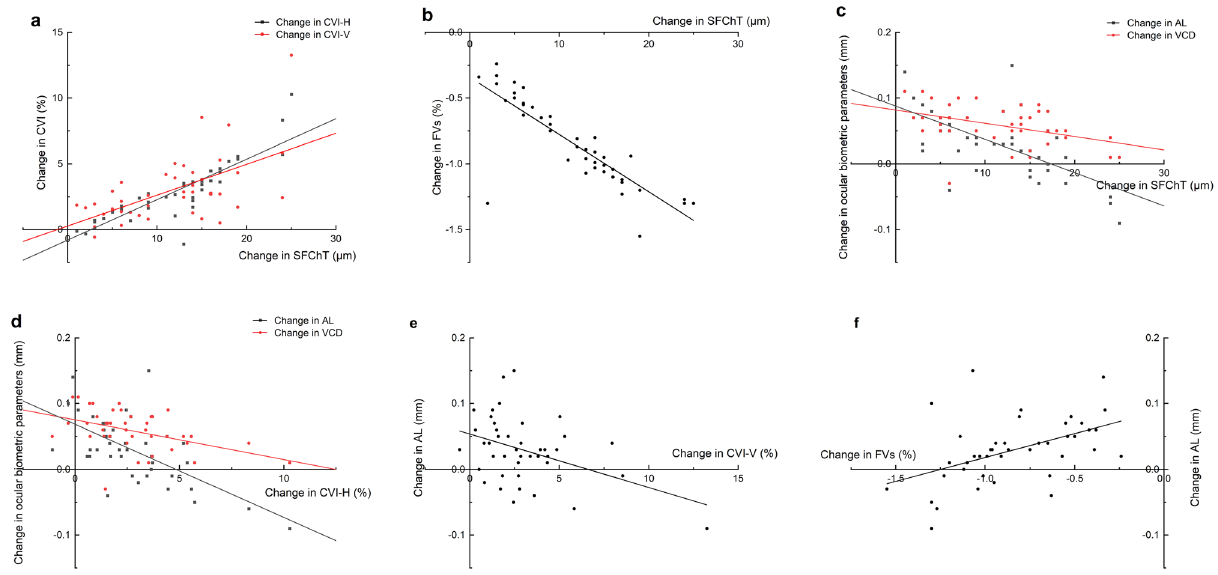
Figure 3. Correlation of the changes in the choroidal parameters with the changes in the ocular biometric parameters. ( a ) The change in the CVI on the horizontal and vertical scans was positively correlated with the change in SFChT; ( b ) the change in the FV% was negatively correlated with the change in SFChT; ( c ) the change in SFChT was negatively correlated with the change in the AL and VCD; ( d ) the change in CVI on the horizontal scans was negatively correlated with the change in AL and VCD; ( e ) the change in the CVI on the vertical scans was negatively correlated with the change in AL; ( f ) the change in the FV% was correlated with the change in the AL. SFChT: sub-foveal choroidal thickness, CVI-H: choroidal vascularity index on the horizontal scan, CVI-V: choroidal vascularity index on the vertical scan, FVs: choriocapillaris flow voids, AL: axial length, VCD: vitreous chamber